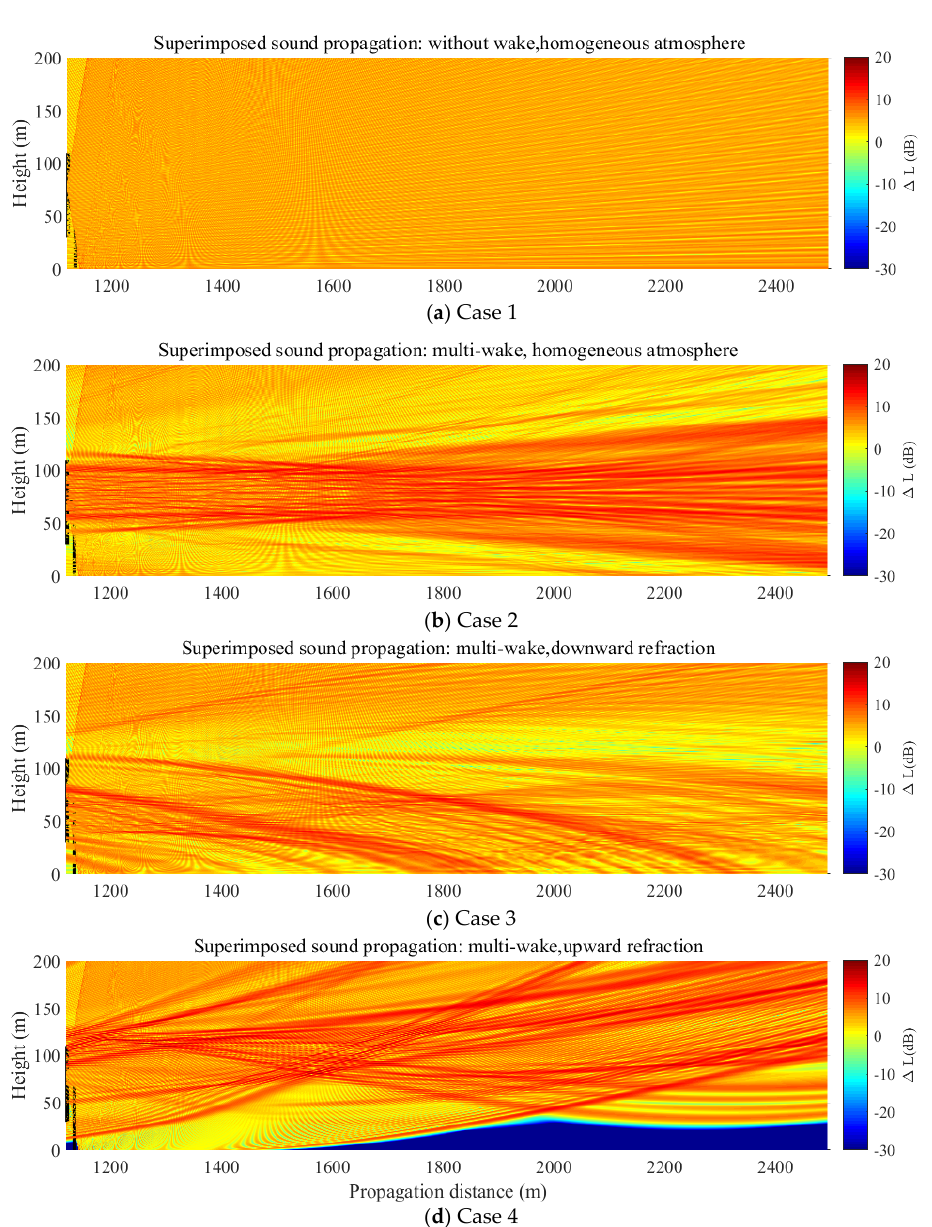
Figure 16. ANPropagation from all ANSources: ( a ) Case 1, homogeneous atmospheric condition, no wake effect; ( b ) Case 2, homogeneous atmospheric condition with multi-wakes; ( c ) Case 3, downward refraction and multi-wakes; ( d ) Case 4, upward refraction and multi-wakes.